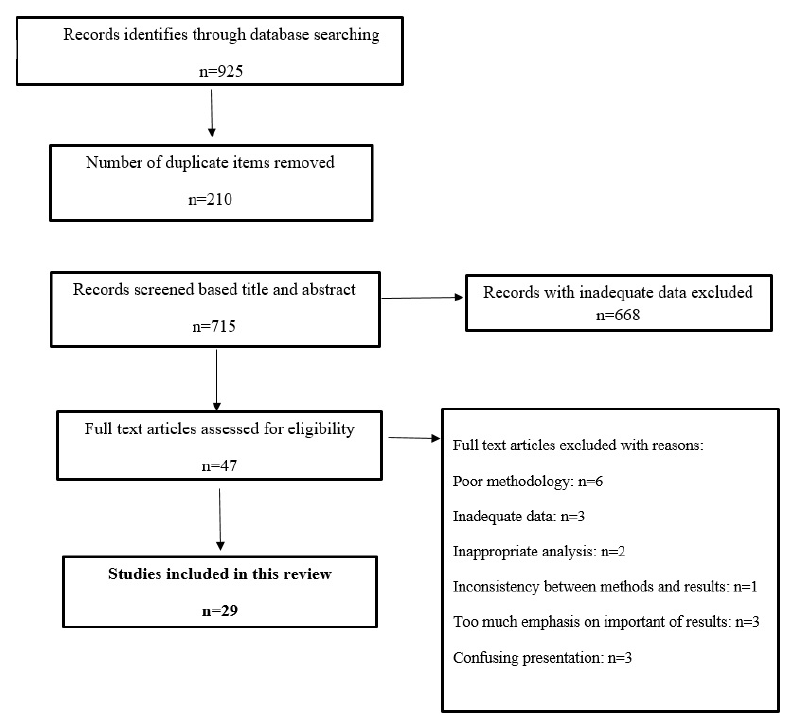
Figure 1. Flowchart describing the study design process .